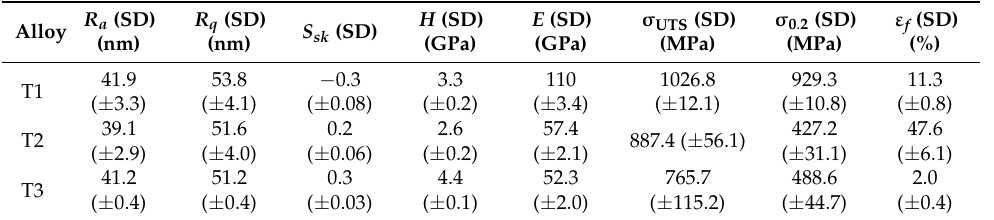
Table 3. Roughness and mechanical parameters for T1, T2, and T3 alloys. Data show the mean and SD values. For each sample, the measurements were performed on three replicates, the results being averaged (arithmetic